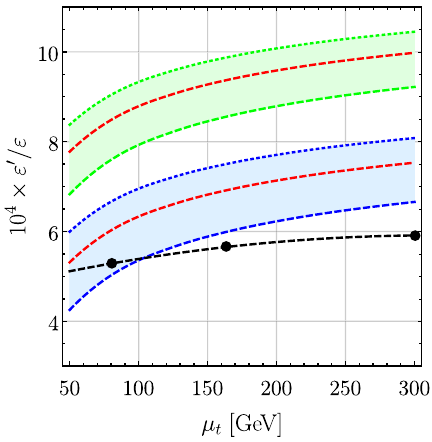
( 1 / 2 ) = 0 . 80 on the scale μ t of 6 ( 3 / 2 ) = 0 . 8